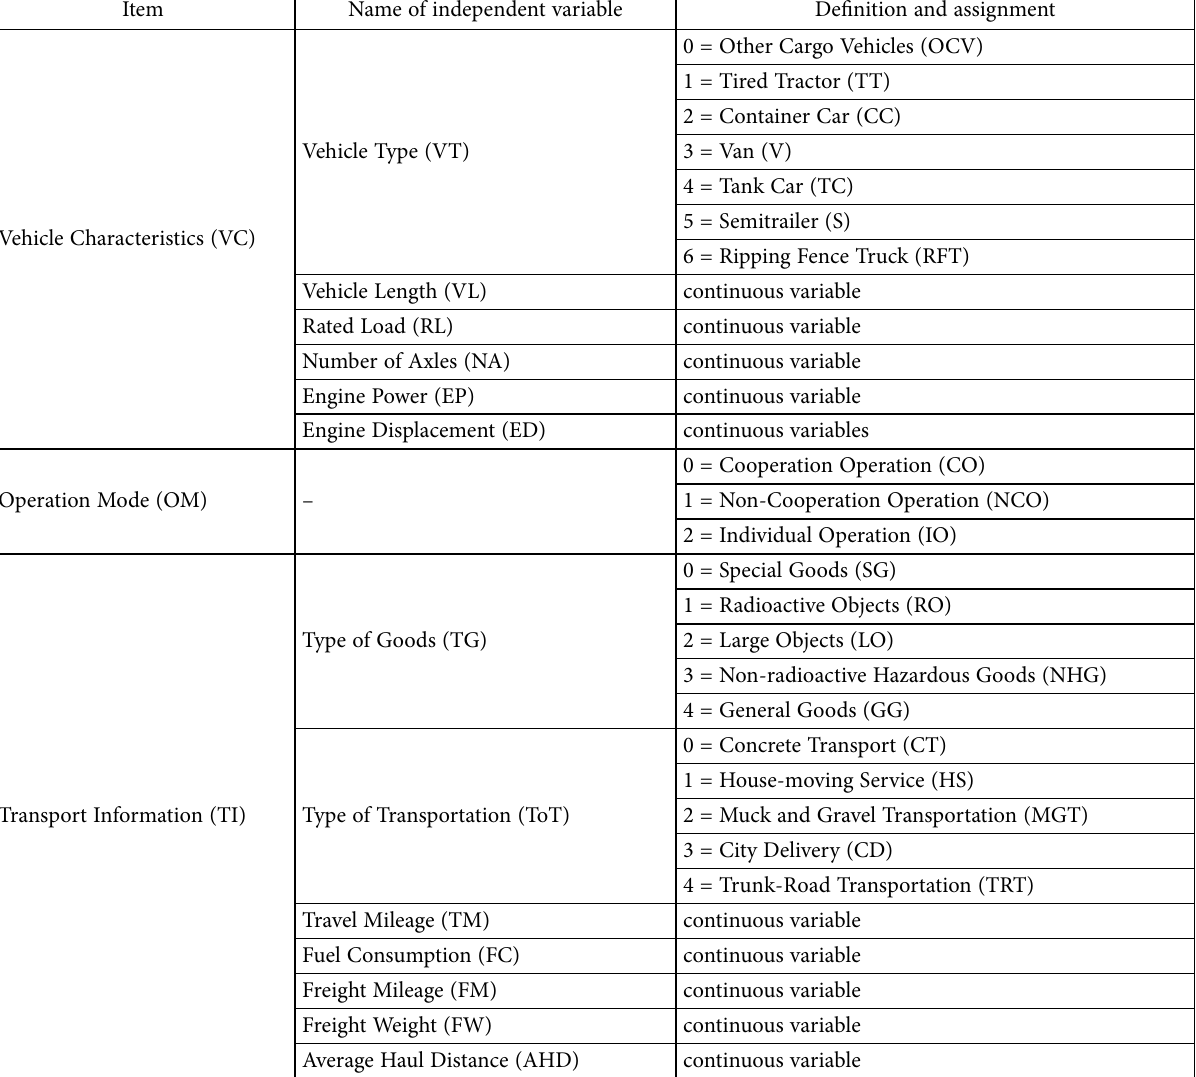
Table 2. Classification and description of independent